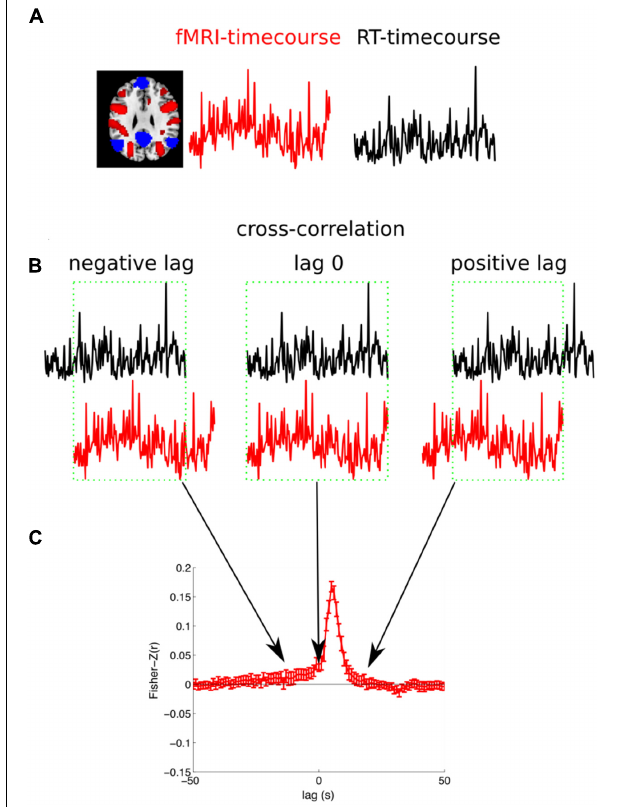
FIGURE 4 | Illustration of the cross-correlation analysis. (A) For each subject and each run the fMRI-timecourse for one voxel and the reaction times for the OG trials are extracted. (B) The correlation between the fMRI-timecourse and the RT-timecourse is calculated. Therefore, the RT-timecourse is shifted in steps of 1 s in the range from –50 s to +50 s. Here a negative lag (fMRI signal is predictive for behavior), zero lag, and a positive lag (the fMRI signals follows after the behavioral response) are illustrated. The overlapping range, illustrated with a green box, is considered for the calculation of the correlation. (C) Finally, the correlation is Fisher-Z transformed. This analysis is repeated for all the six runs for each subject and averaged. The subject specific cross-correlation can then be used for group